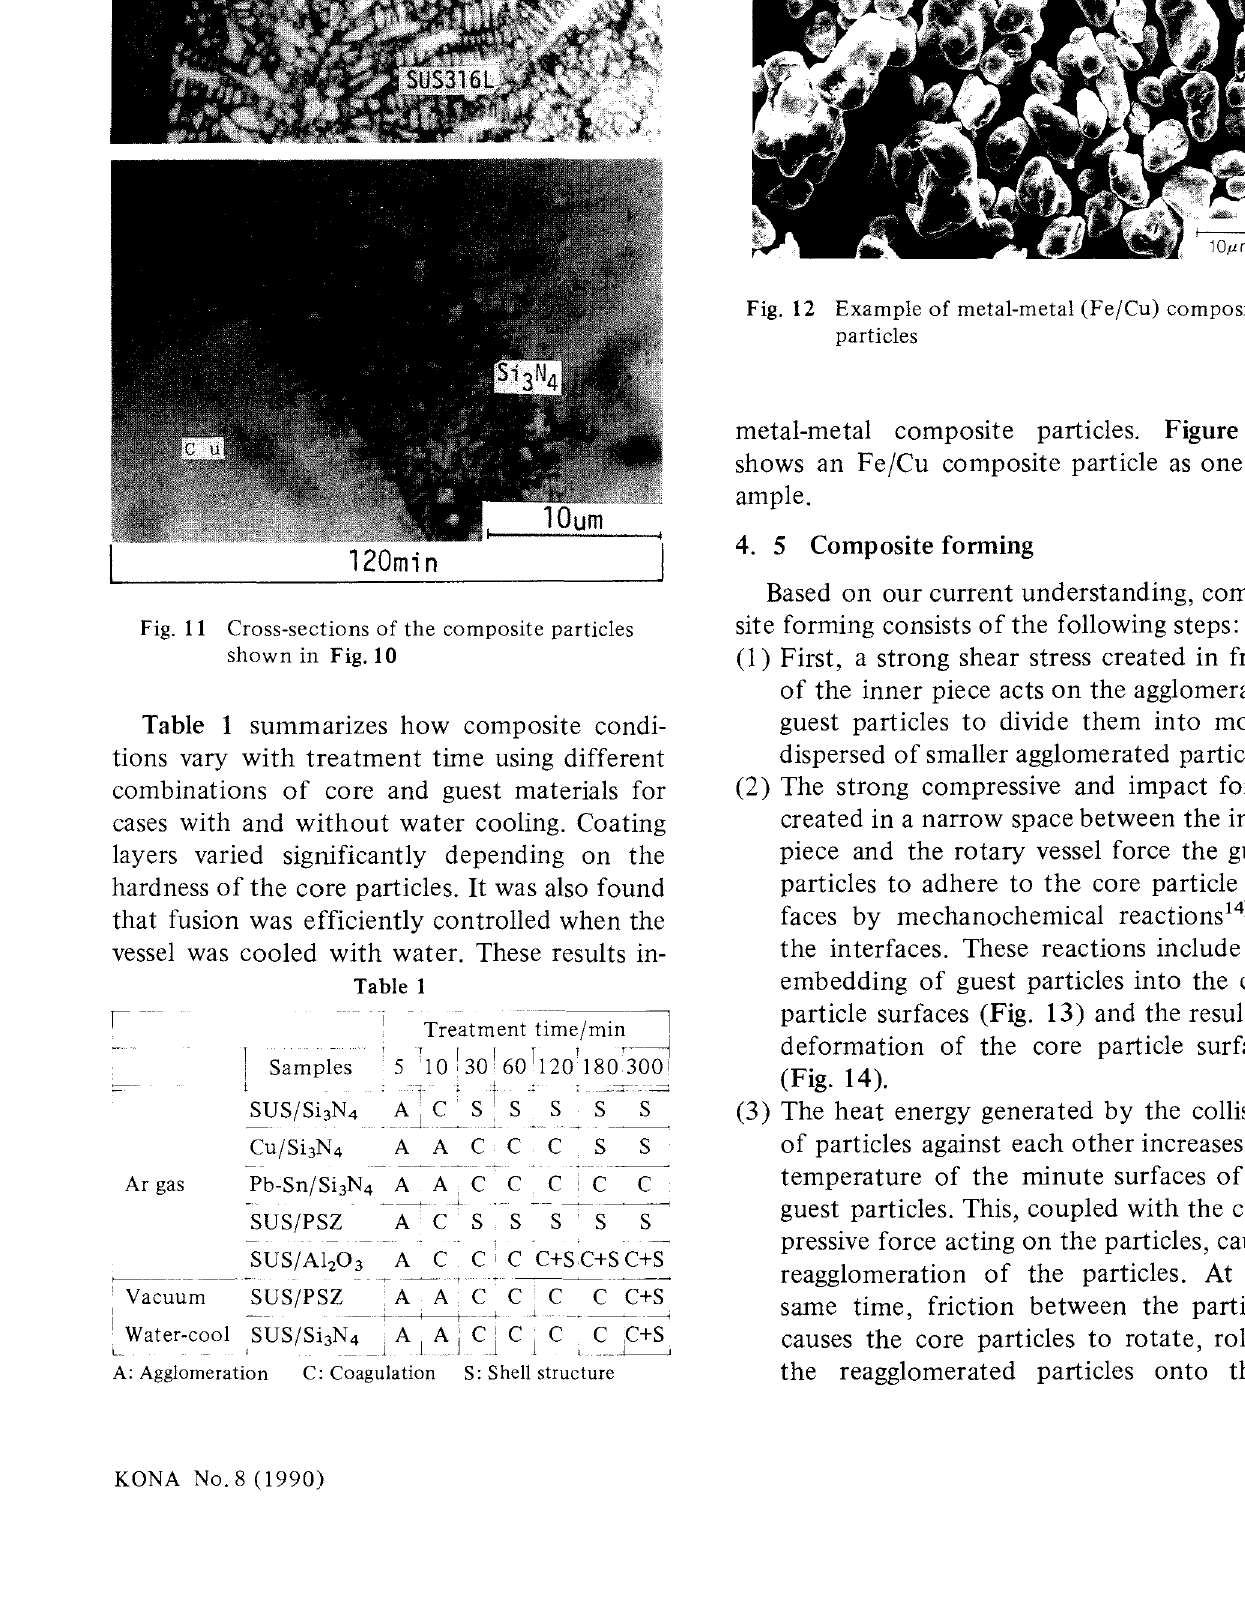
Fig. 12 Example of metal-metal (FejCu) composite